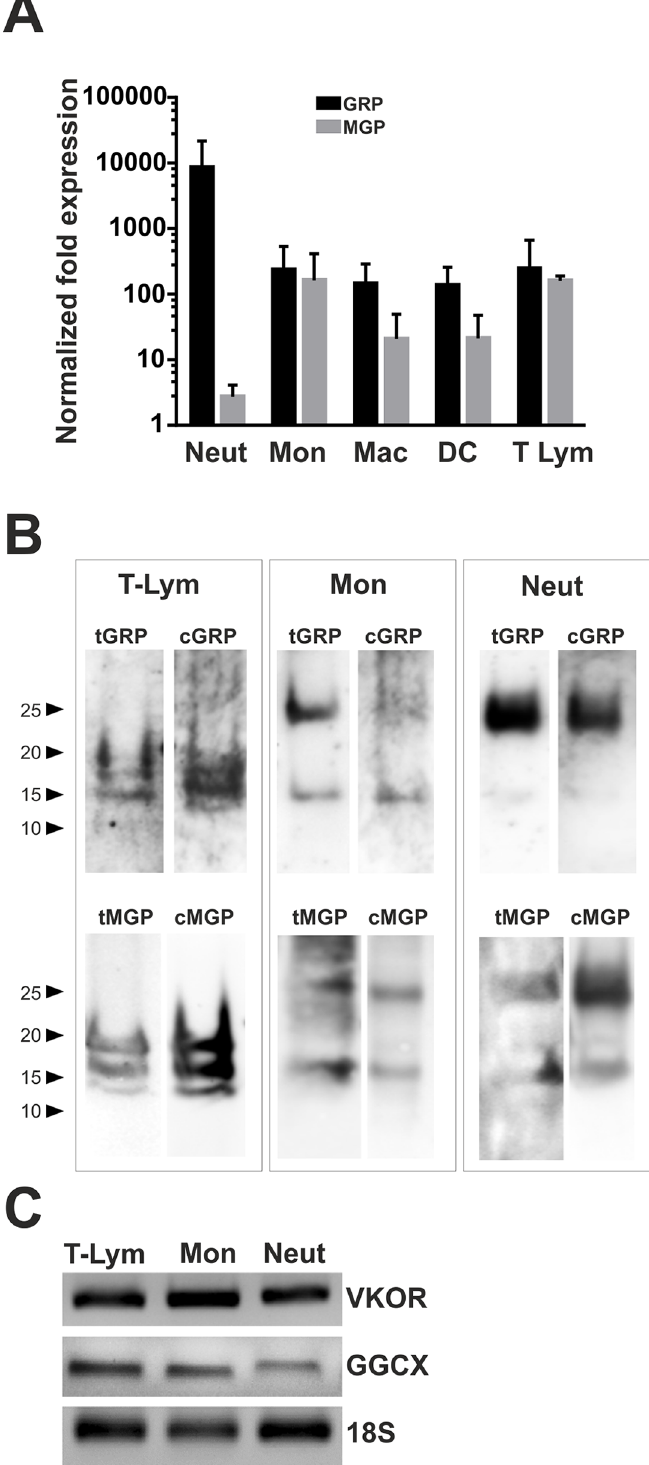
Fig 1. GRP and MGP are produced by leukocytes as γ -carboxylated proteins. Leukocyte subsets neutrophils(Neut), monocytes (Mon), and T lymphocytes (T-Lym) were isolated from humanbuffy coats, and macrophages (Mac) and dendriticcells (DC) were obtained by differentiation of isolated monocytes in culture. After purity assessment by flow cytometry, these isolatedleukocyte populations were used to evaluateGRP